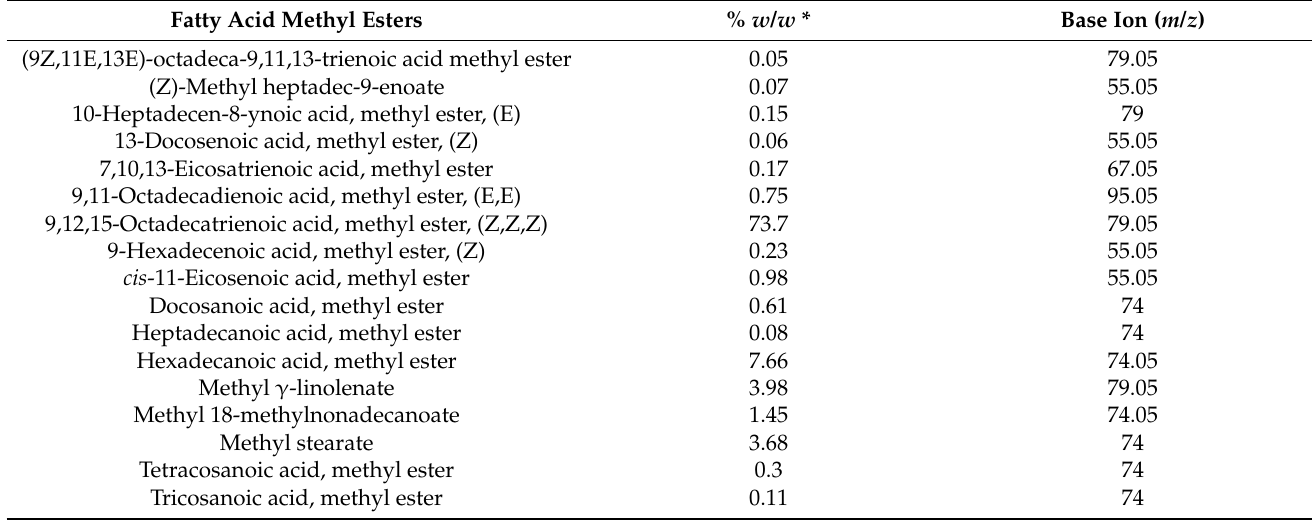
Table 1. Fatty acid methyl esters determined in saponifiable matter of the working hemp seed oil sample.